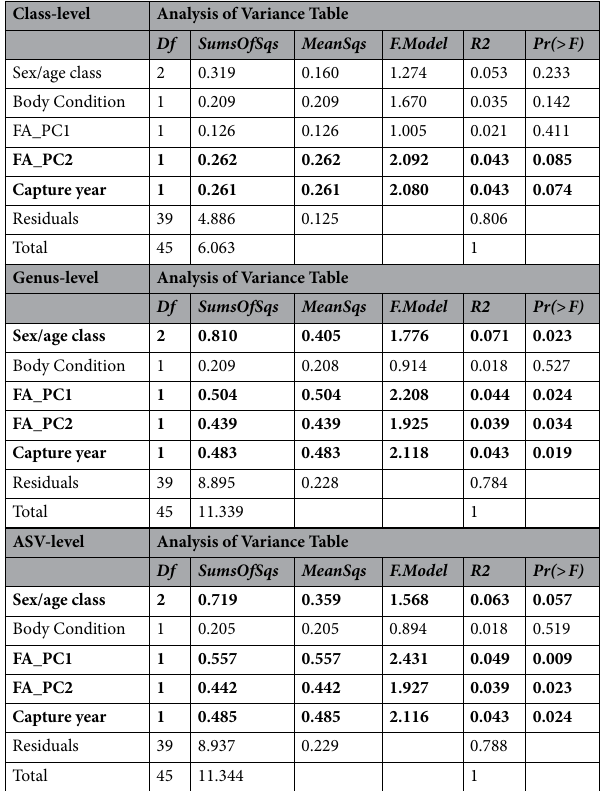
Table 3. Summary of permutational analysis of variance (PERMANOVA) results* assessing differences in gut bacterial composition at bacterial class, genus, and amplicon sequence variant (ASV)-levels for the subset of Southern Beaufort Sea (SB) polar bears using Bray–Curtis distances. *Significant terms are in bold